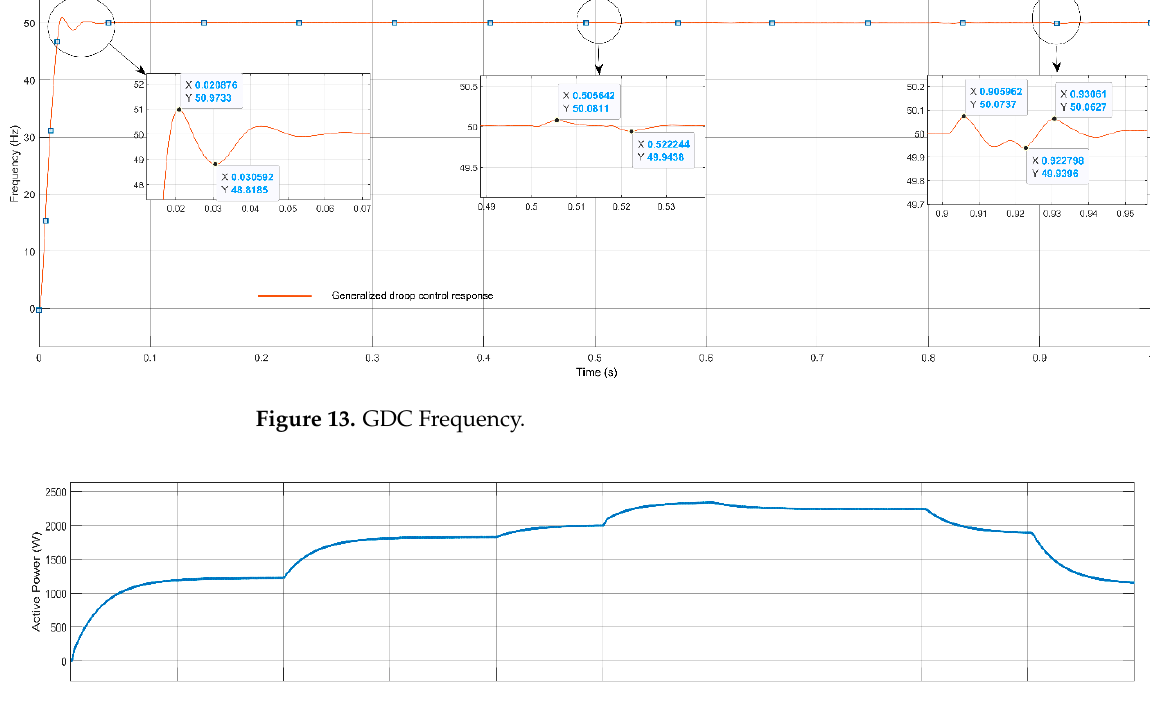
Figure 12. DC link voltage.